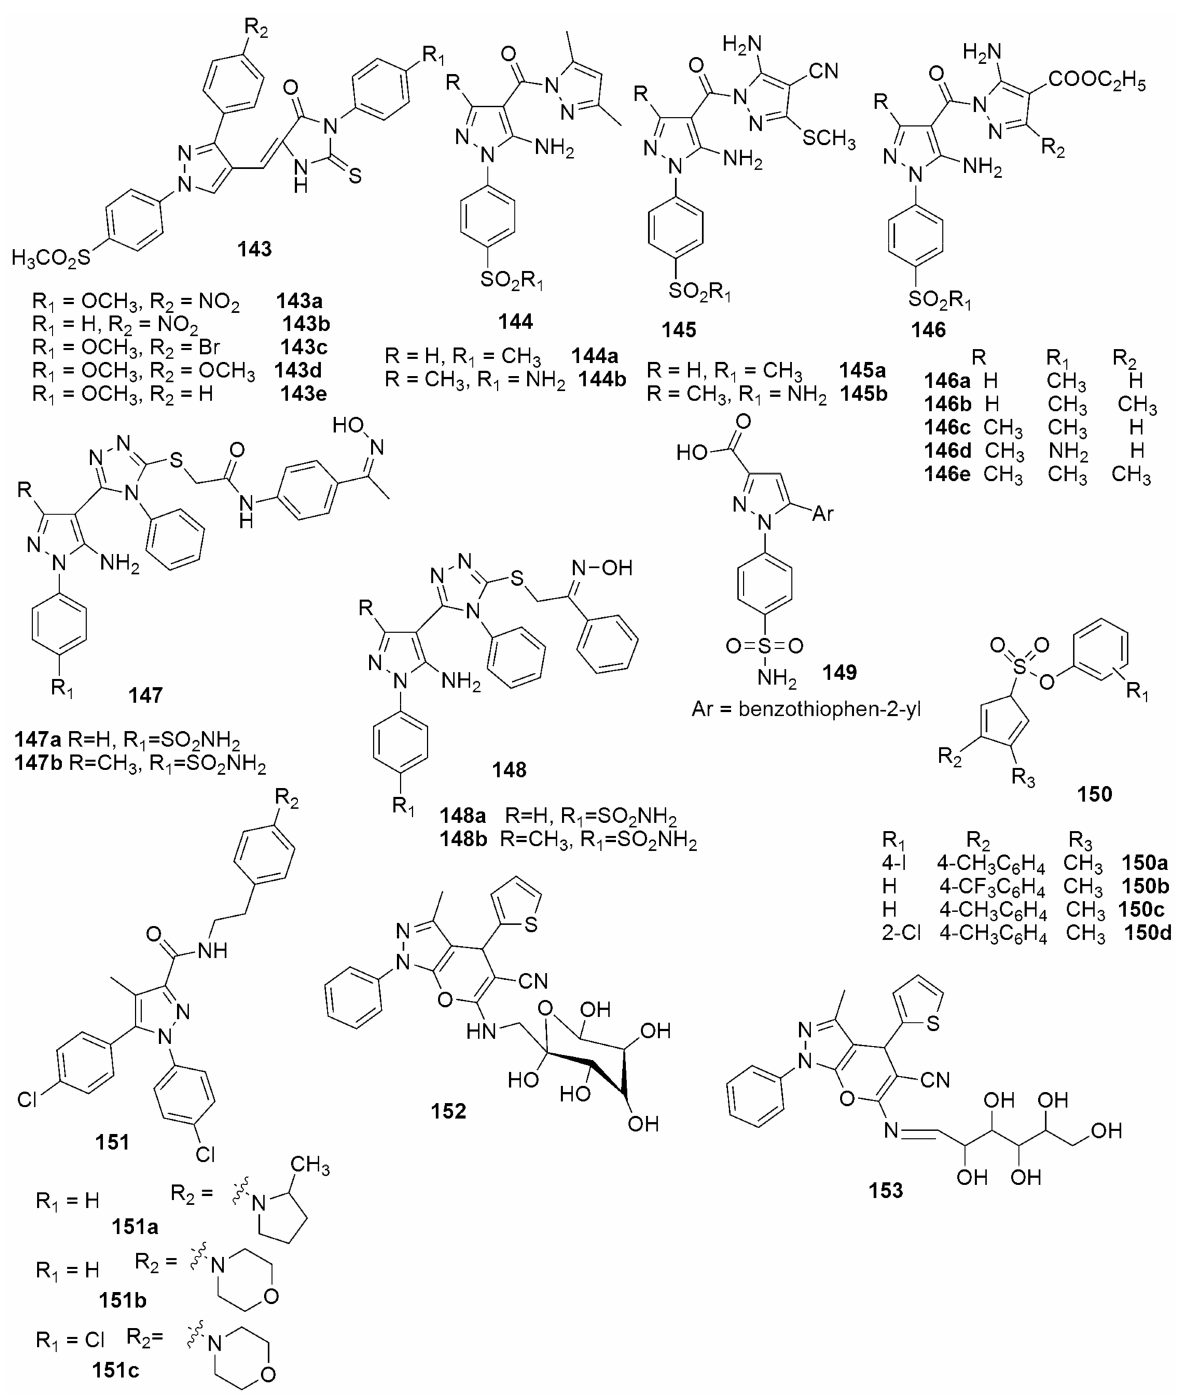
Figure 5. Structures of promising pyrazole derivatives with anti-inflammatory and analgesic